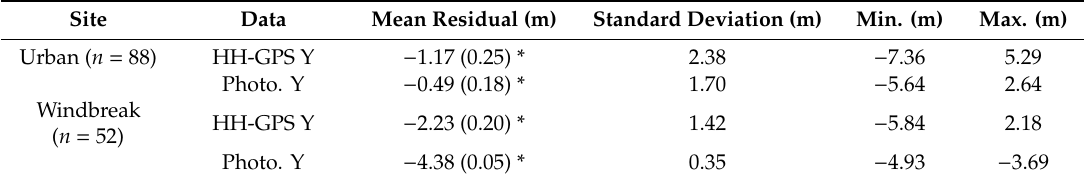
Table 3. A comparison of Y-coordinate di ff erences for tree positions between satellite interpreted coordinates from handheld GPS (HH-GPS) and photogrammetry (Photo.).